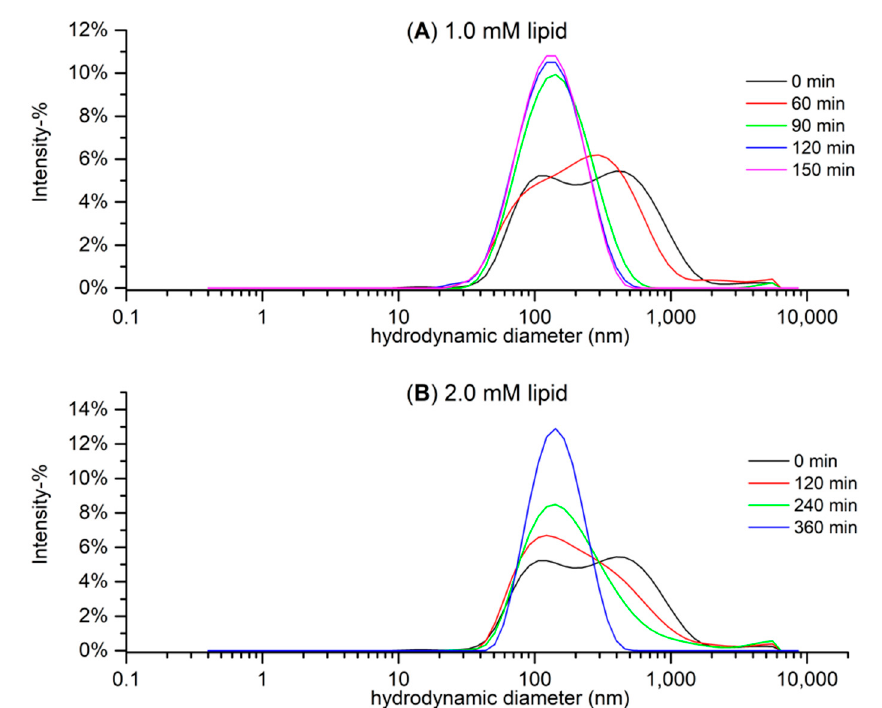
Figure 6. Hydrodynamic particle size distribution based on the intensity of ( A ) five 1.0 mM and ( B ) three 2.0 mM E. coli lipid extract solutions differing in the time they were sonicated after freeze– thaw treatment measured with dynamic light scattering (DLS). Note that the non ‐ sonicated (0 min) sample of (B) was the 1.0 mM sample, as the non ‐ sonicated version was not measured in 2.0 mM.